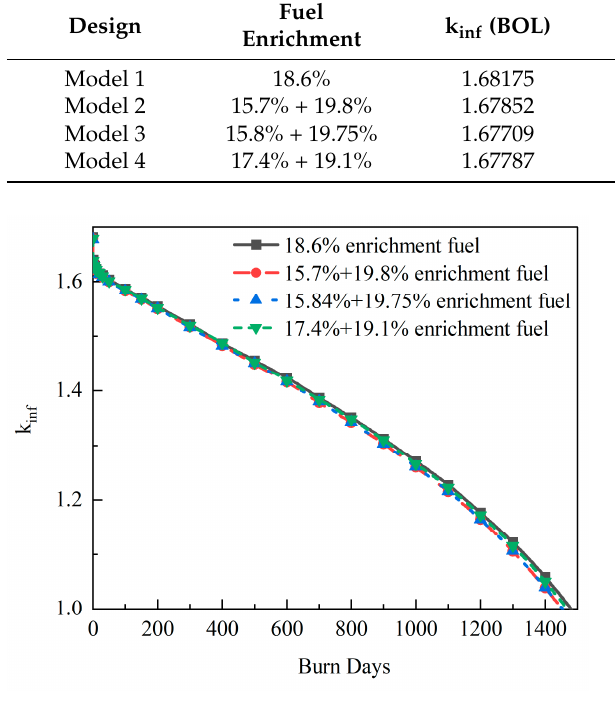
Figure 12. Burnup curves of different power-flattening designs with EFPD.